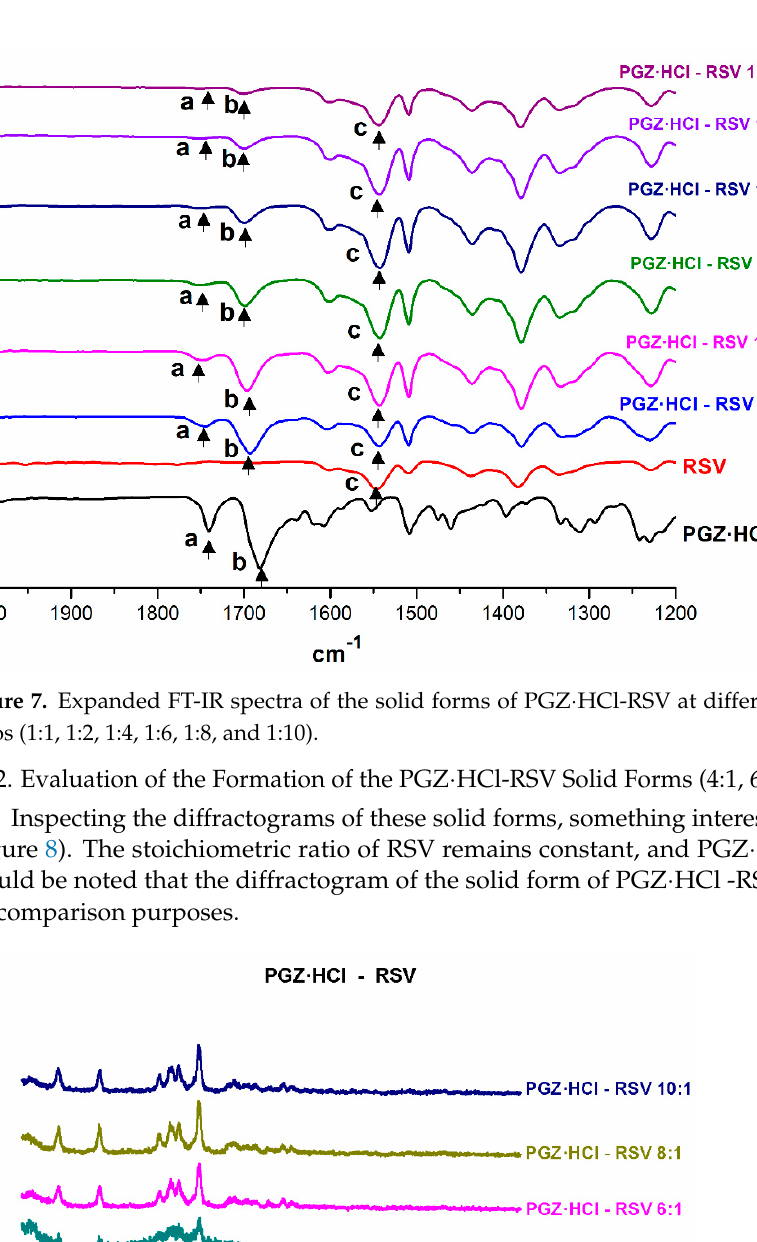
12 of 21 Table 4. Vibrational band assignment of the solid forms of PGZ·HCl-RSV at different stoichiometric ratios (1:1, 1:2, 1:4, 1:6, 1:8, and 1:10). Vibrational Band Assignment PGZ·HCl RSV PGZ·HCl-RSV (1:2)